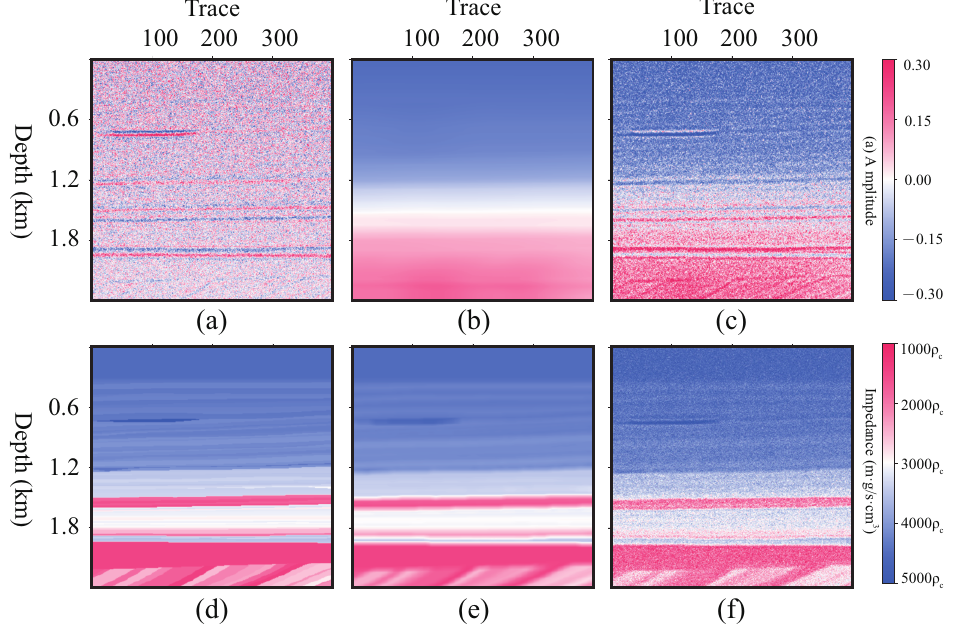
Figure 22. Profiles of TV regularization. ( a ) M , seismic profile, ( b ) B 100 × 100 , background impedance profile, smooth filter size = 100, ( c ) predicted profile ˆZ by ( a , b ), ( d ) label profile Z , ( e ) B 10 × 10 , background impedance profile, smooth filter size = 10, ( c ) predicted profile ˆZ by ( a , e ). ( f ) predicted profile ˆZ by ( a , e